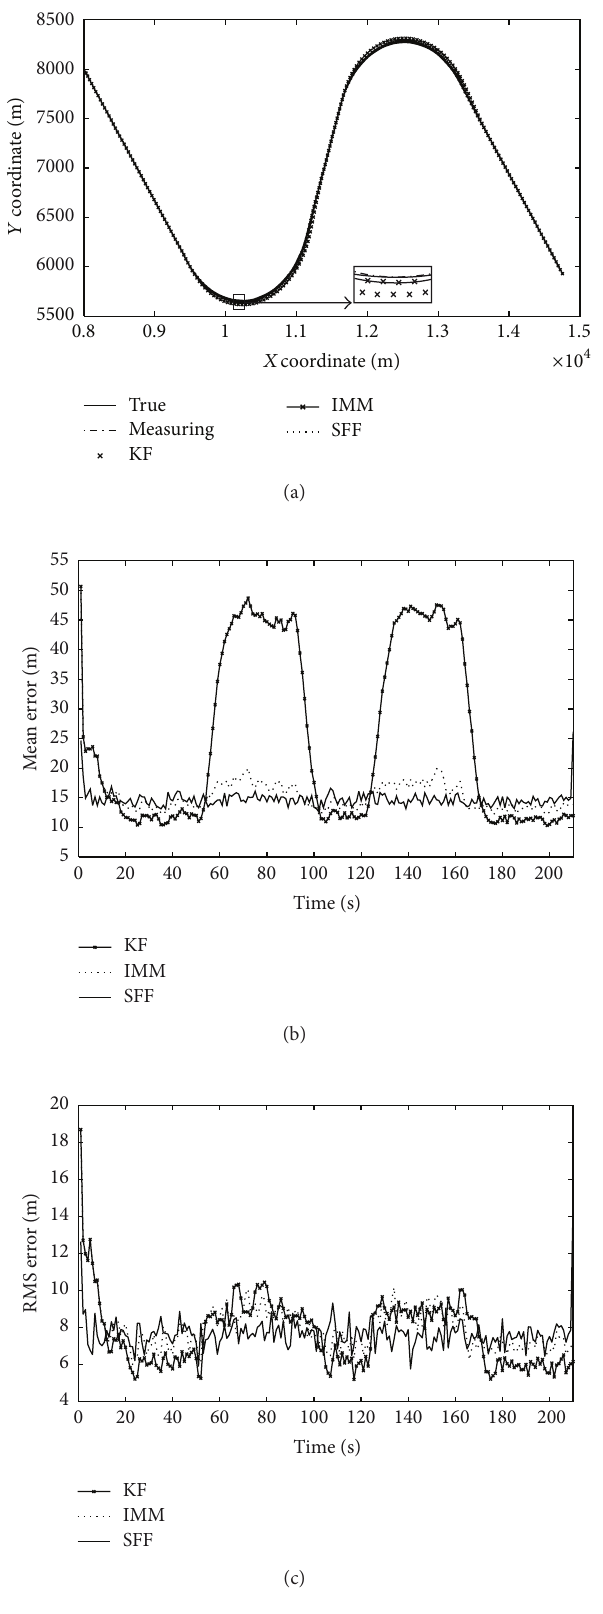
algorithm and maintains a simple structure and small amount of storage. Conflict of